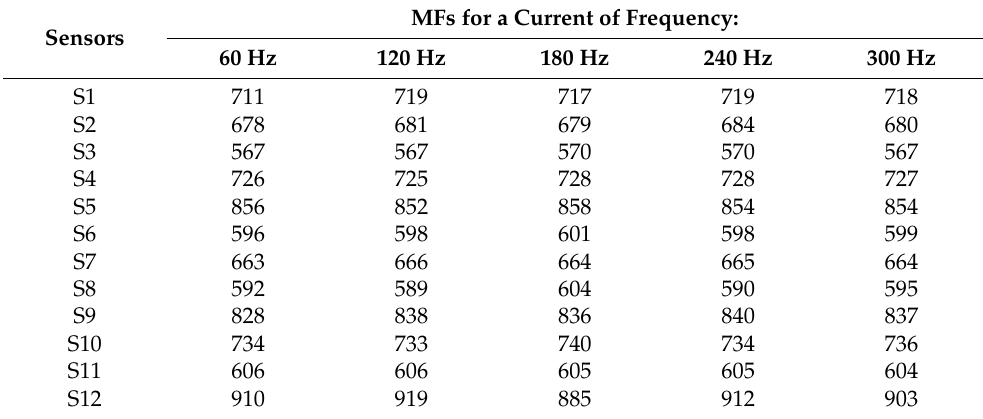
Table 2. Multiplying factors for all sensors with application of 5 A current for various harmonics. Sensors